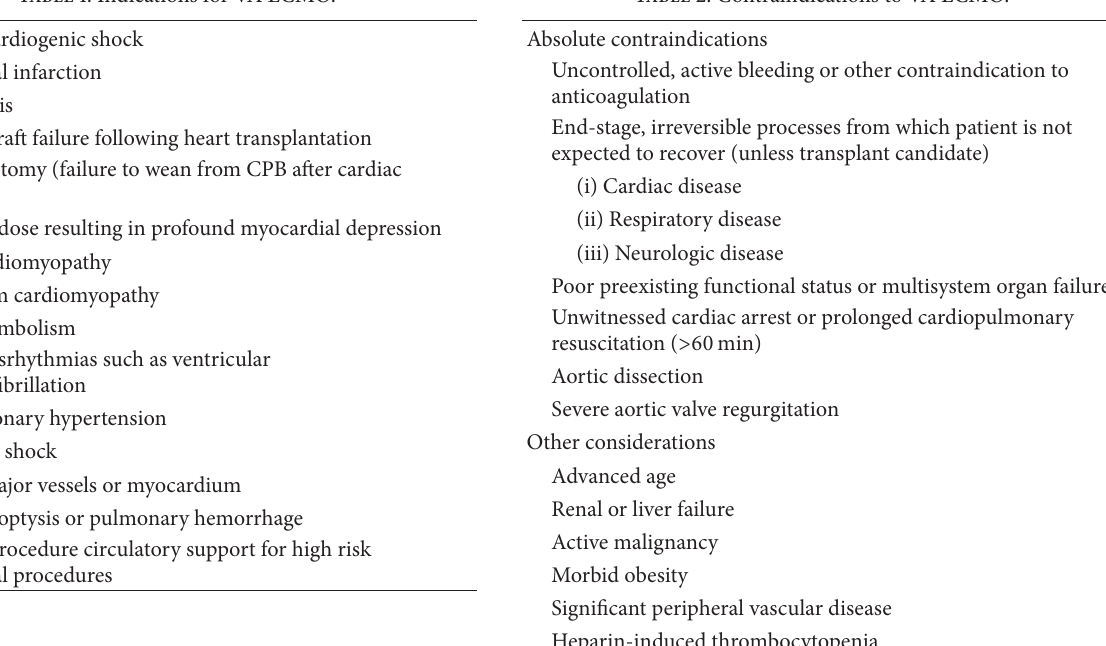
Table 1: Indications for VA ECMO. Table 2: Contraindications to VA